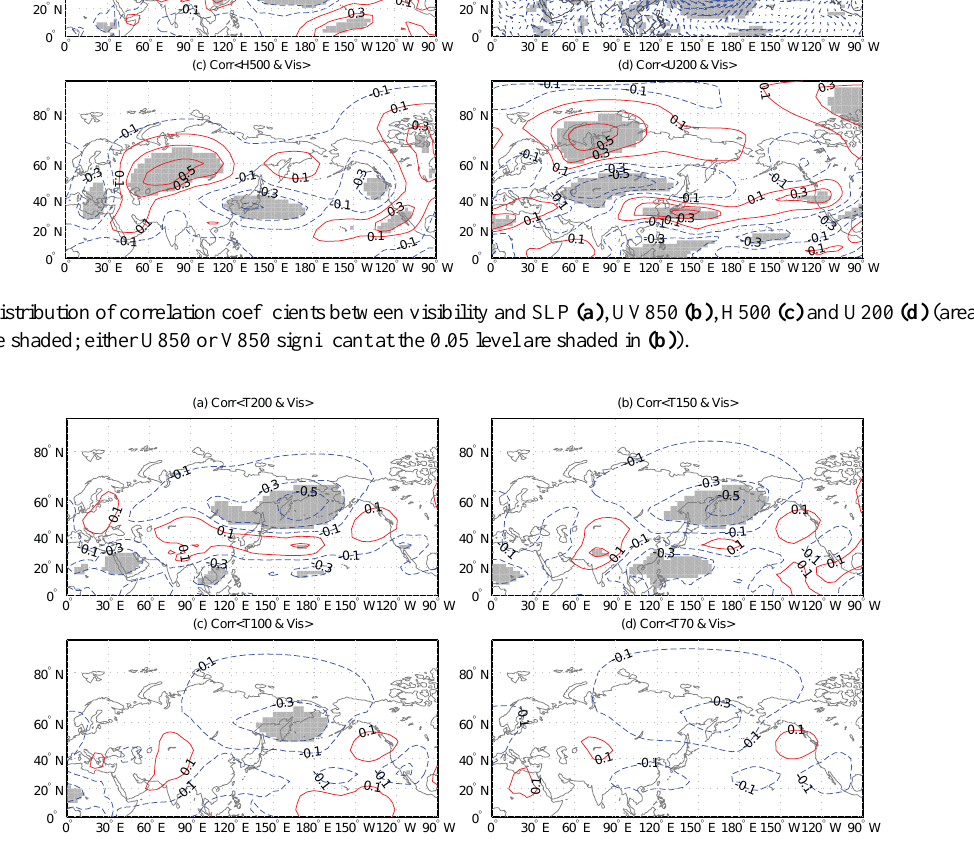
Figure 4. Spatial distribution of correlation coefficients between visibility and T200 (a) , T150 (b) , T100 (c) and T70 (d) (areas significant at the 0.05 level are